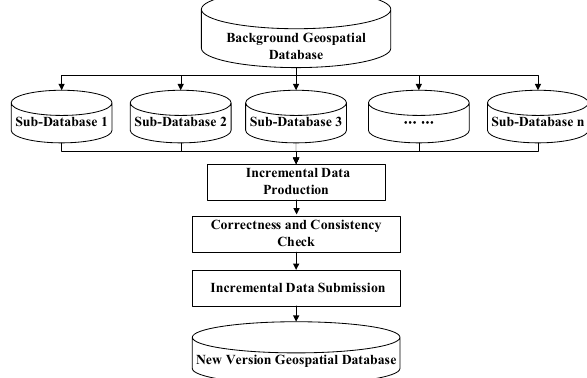
Figure 1 . General design of the dynamic updating method.